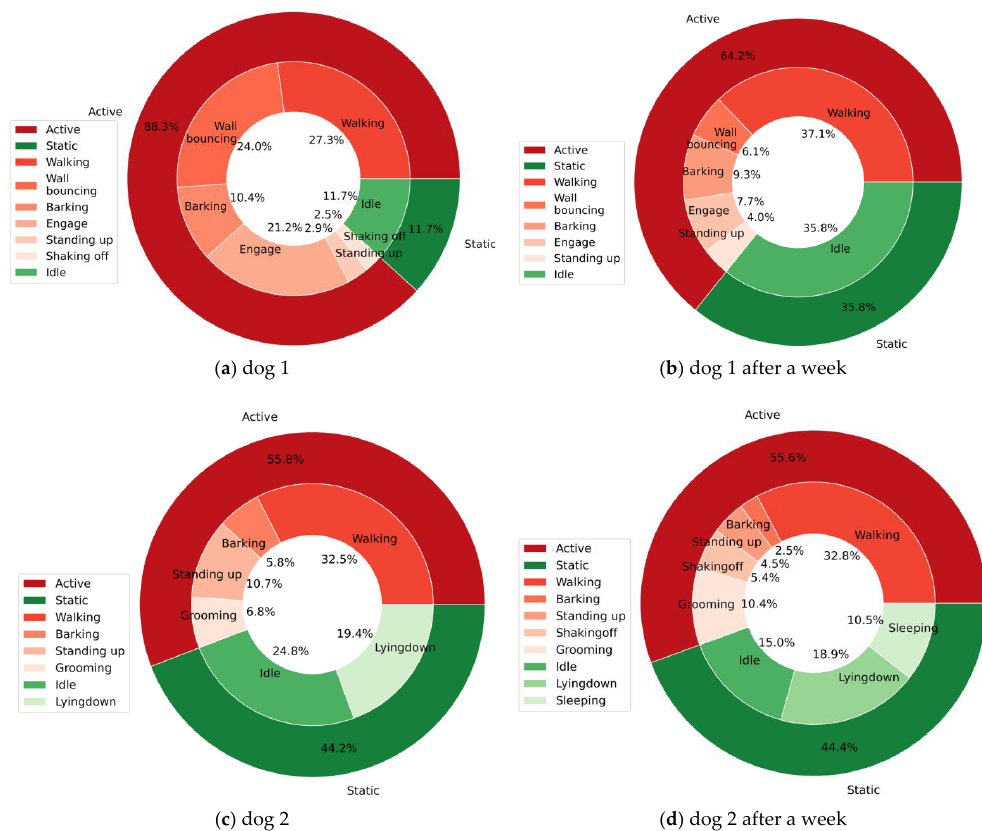
Figure 10. Nested doughnut charts for visual summarization of dog’s static and active behaviors: ( a , b ) example of two scenarios a week apart with dog 1; ( c , d ) example of two scenarios a week apart with dog 2.